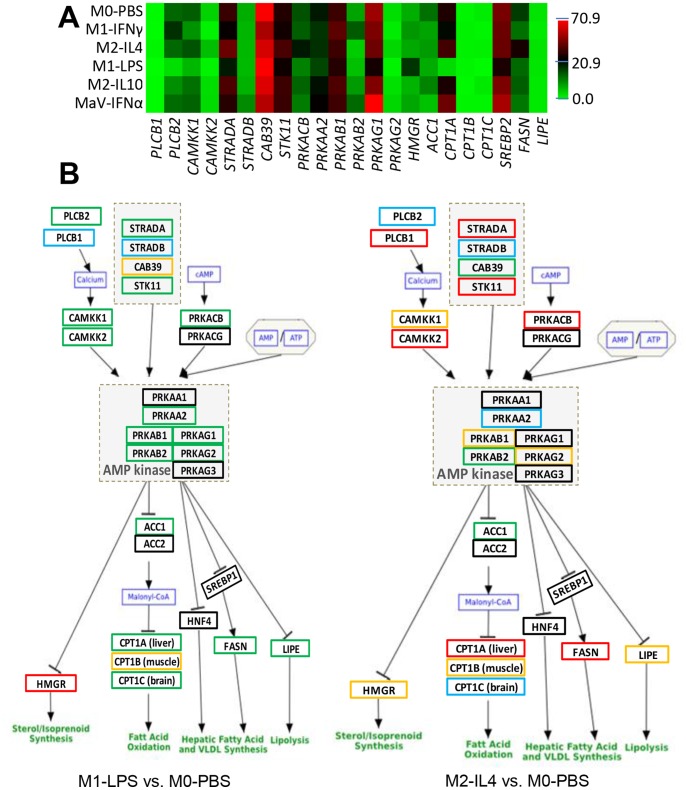
AMPK-mediated pathways for antiviral regulation.(A) Heatmap of the subset DEGs in the AMP-kinase pathway, which is critical to control of lipid metabolism, are shown. (B) As illustrated in the pathway, most key genes in the M1 statuses (IFNγ- or LPS-induced) or IFNα-antiviral state (MaV) were differentially regulated, leading to a general suppression of lipid metabolism in contrast to a general increase in the M2-IL4 status. In addition, the illustration of AMPK-mediated pathways in other statuses is presented in Figure S3 together with the dose-dependent suppression of PRRSV infection by two AMPK-pathway activators. Legend: green-line box, significant suppression; blue-line box, non-significant suppression; red-line box, significant up-regulation; yellow-line box, non-significant up-regulation; and black-line box, non-significant detection. p (FDR) <0.001, fold change ≥2 for significant determination.